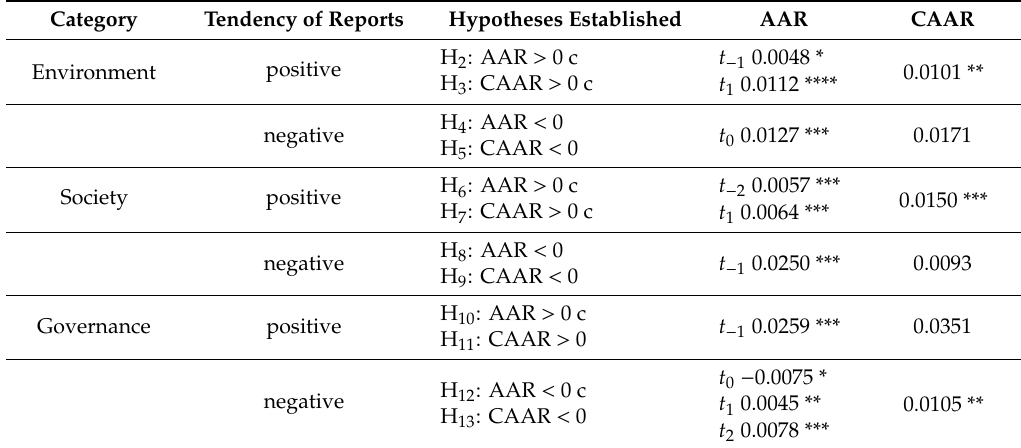
Table A4. Results of robustness check (126